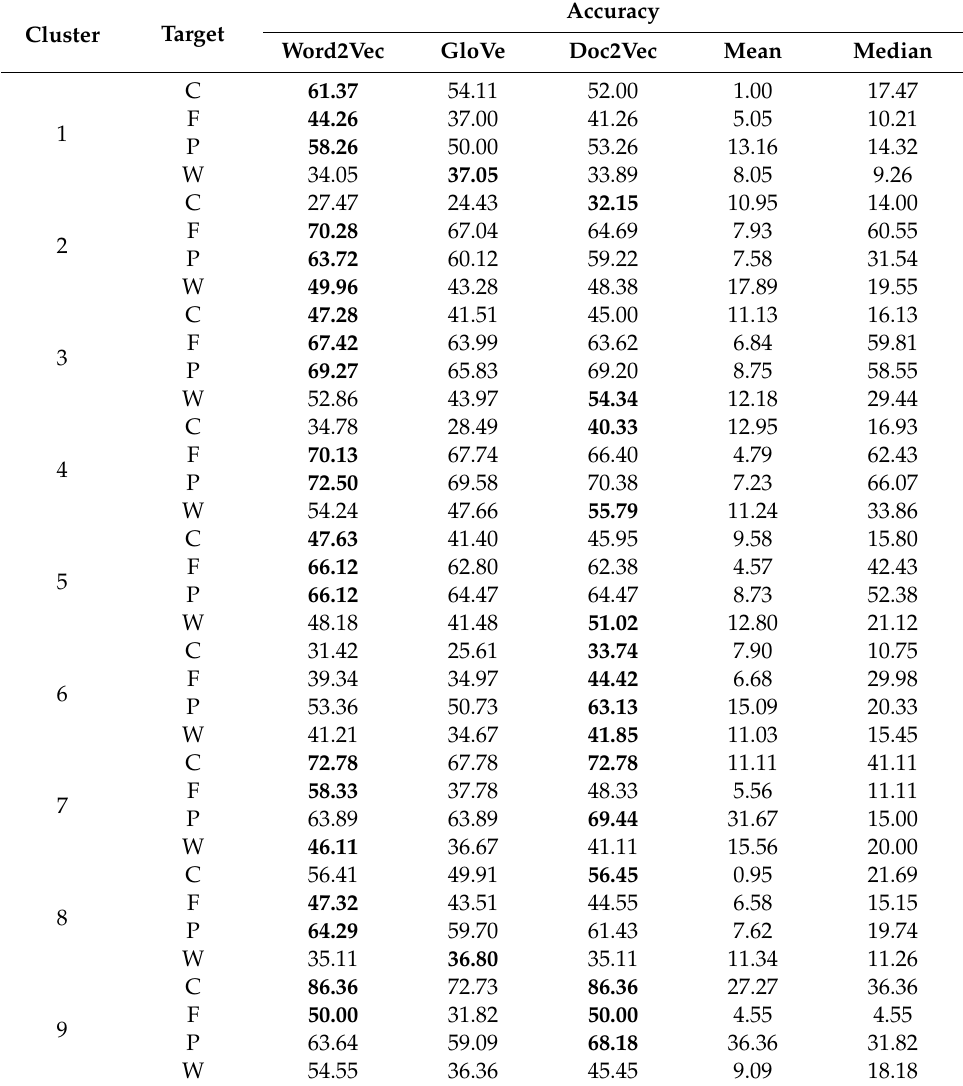
Table6. Accuracypercentagesafterk-foldcrossvalidationoneachclusterobtainedwiththeembeddings for the Slovene names of the food products. Target: C—Carbohydrates, F—Fat, P—Protein, W—Water. The bolded numbers in the table represent the overall best performance for each macronutrient in the given